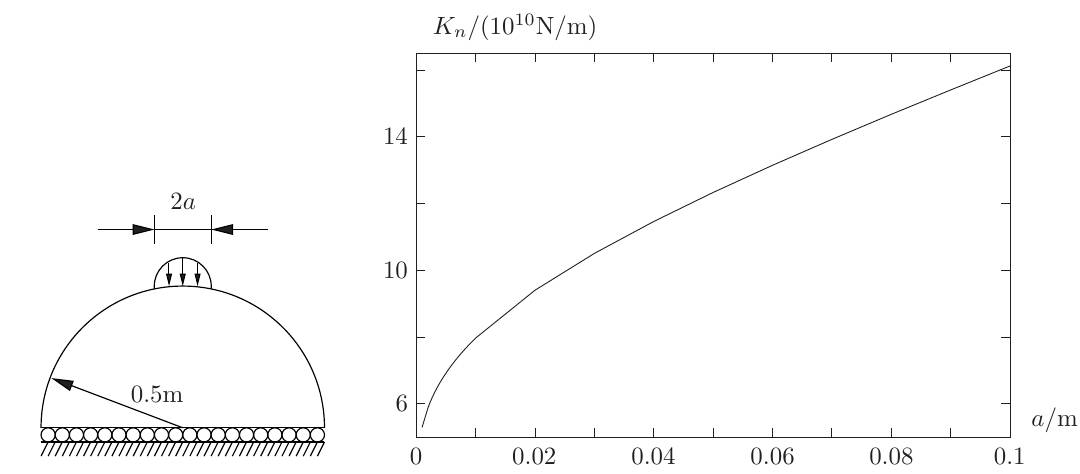
Figure 8: Stiffness of half a cylinder (radius 0 . 5m and length 1m) as a function of the contact zone half-width.